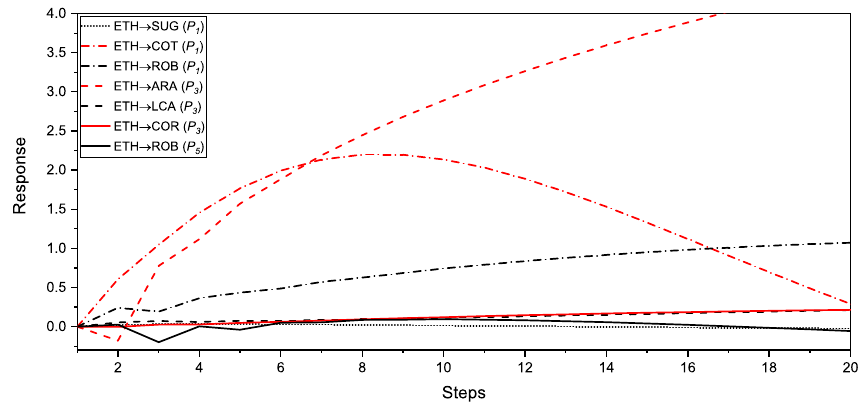
Figure 4. The responses of the agricultural commodities prices from an orthogonal impulse (OIR) in the ethanol prices.